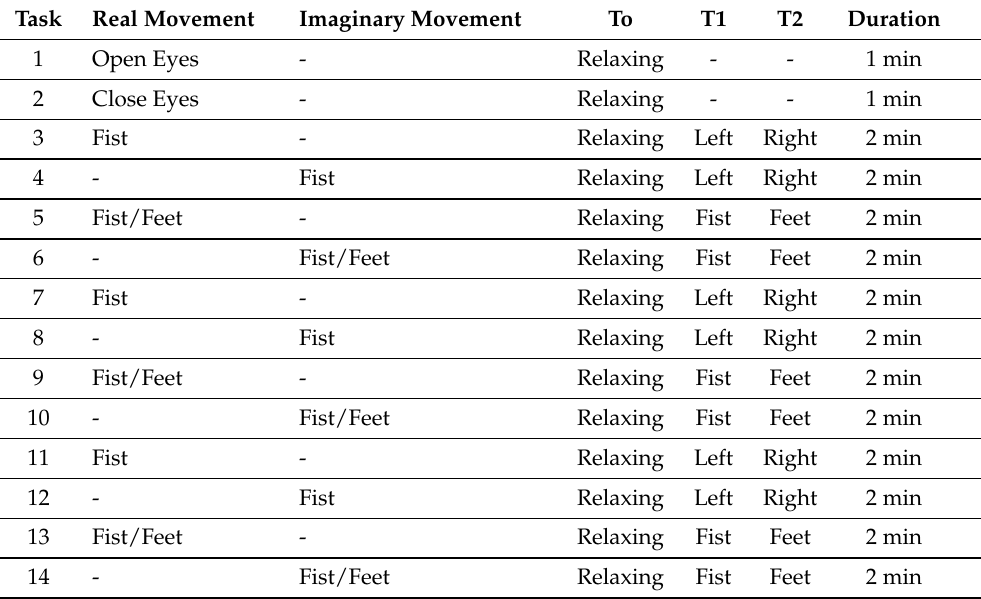
Table 1. Tasks presented in the dataset to train the ML algorithms for EEG signal classification.